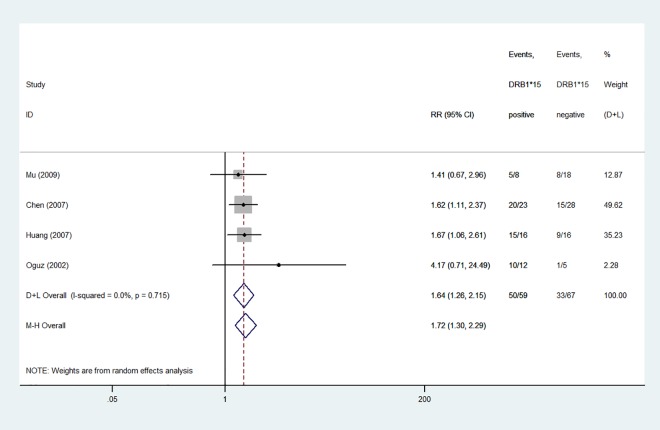
Forest plot of relative ratios for overall response rate between HLA-DRB1*15+ and HLA-DRB1*15− patients.